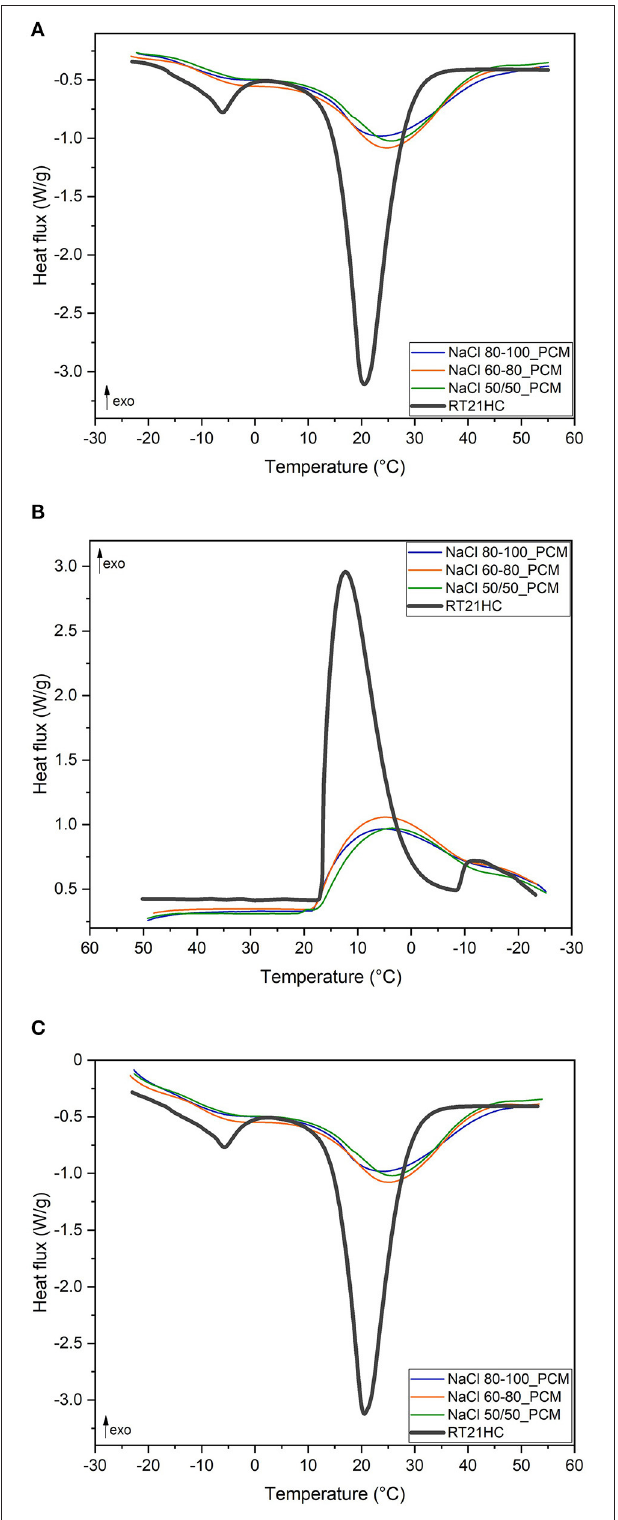
FIGURE 4 | Differential scanning calorimetry (DSC) curves of the TES-EPDM foams and phase change material (PCM) at ± 10 ◦ C/min: (A) first heating scan, (B) cooling scan, and (C) second heating